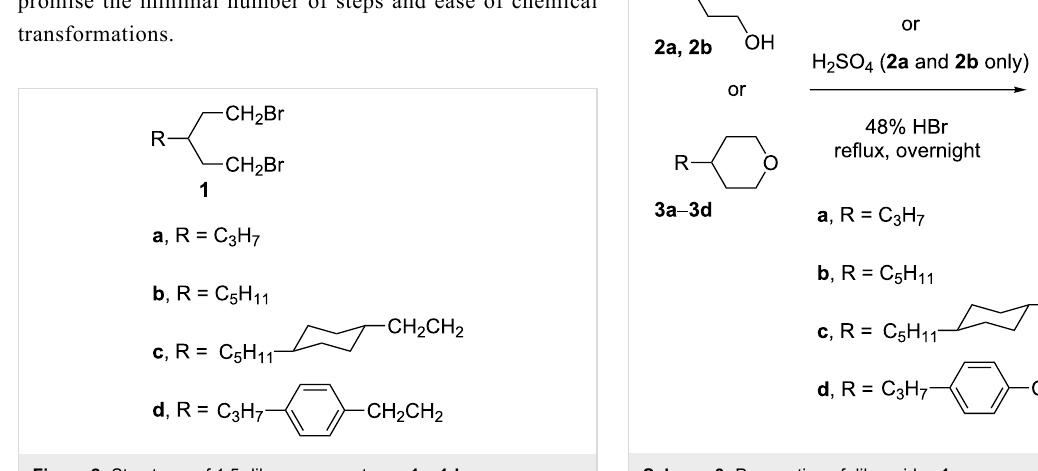
Figure 2: Structures of 1,5-dibromomopentanes 1a – 1d . Scheme 3: Preparation of dibromides 1 .